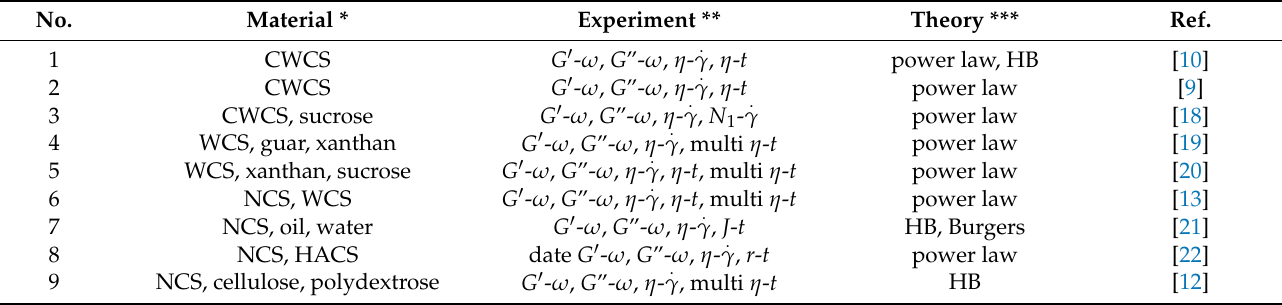
Table 1. Viscoelastic properties of corn starch pastes in some